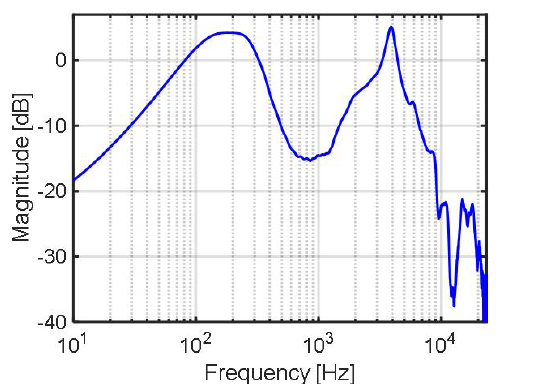
Figure 6. Transfer function of the primary path P ( z ) , with the noise incidence angle of ( a ) 0 ◦ , ( b ) 90 ◦ .